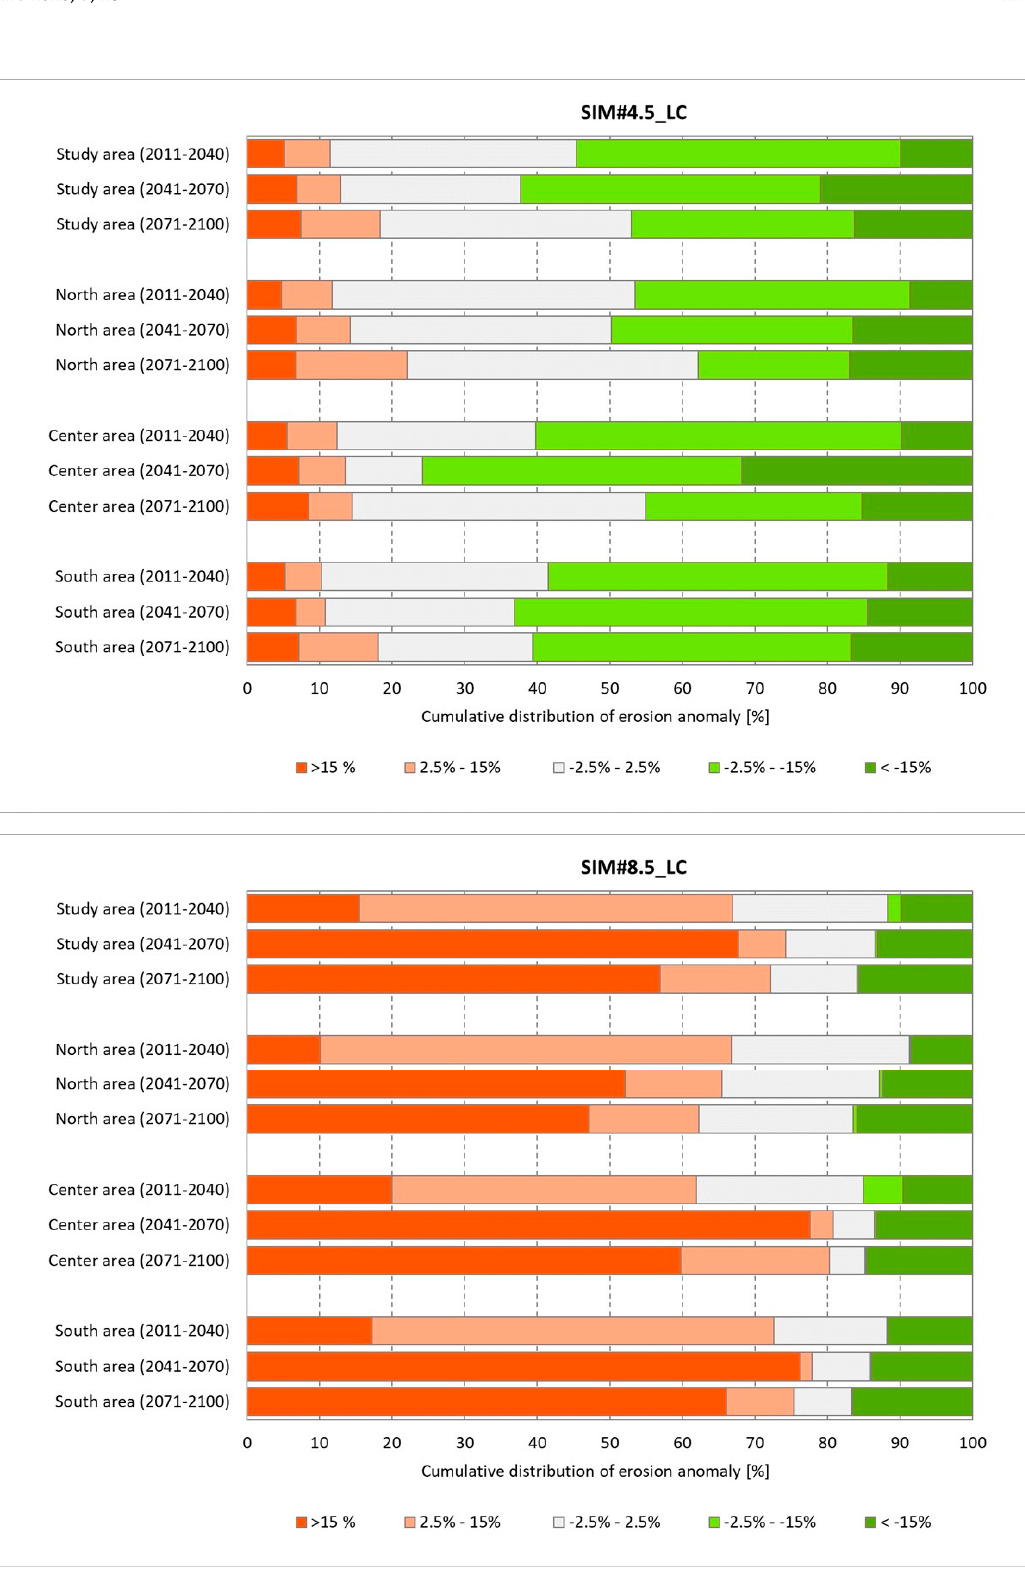
Figure 17. Erosion anomaly with respect to the reference period (1981–2010) expressed as percentage of territory for SIM#4.5_LC (on the top) and SIM#8.5_LC (on the bottom).